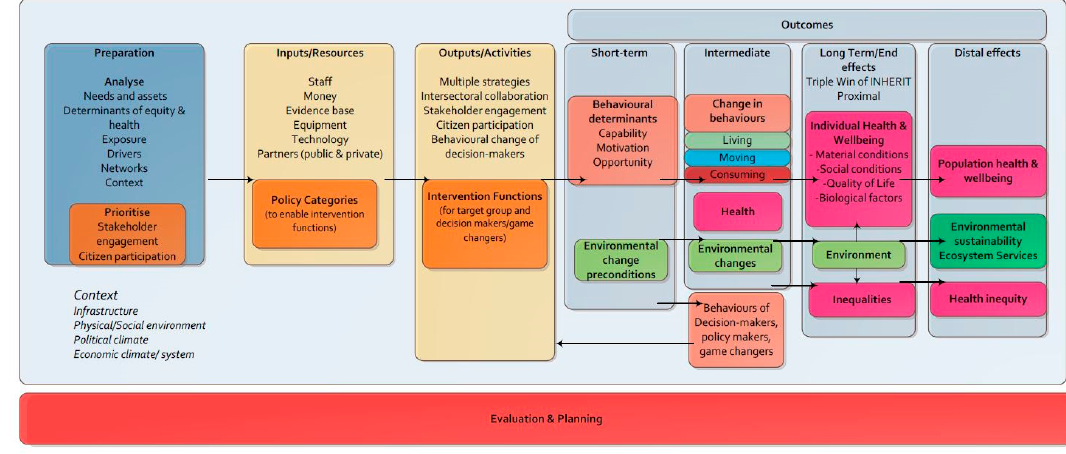
Figure 1. The INHERIT generic logic model.